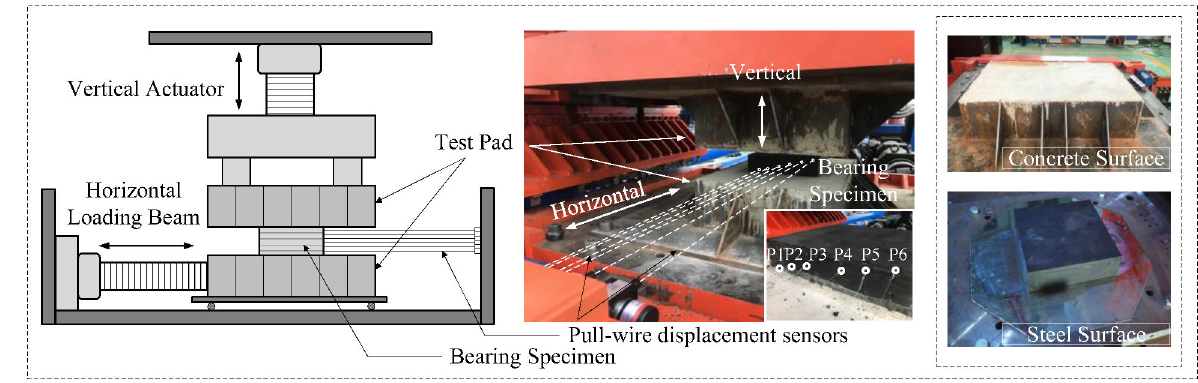
Figure 4. Specimen installation and test pad.